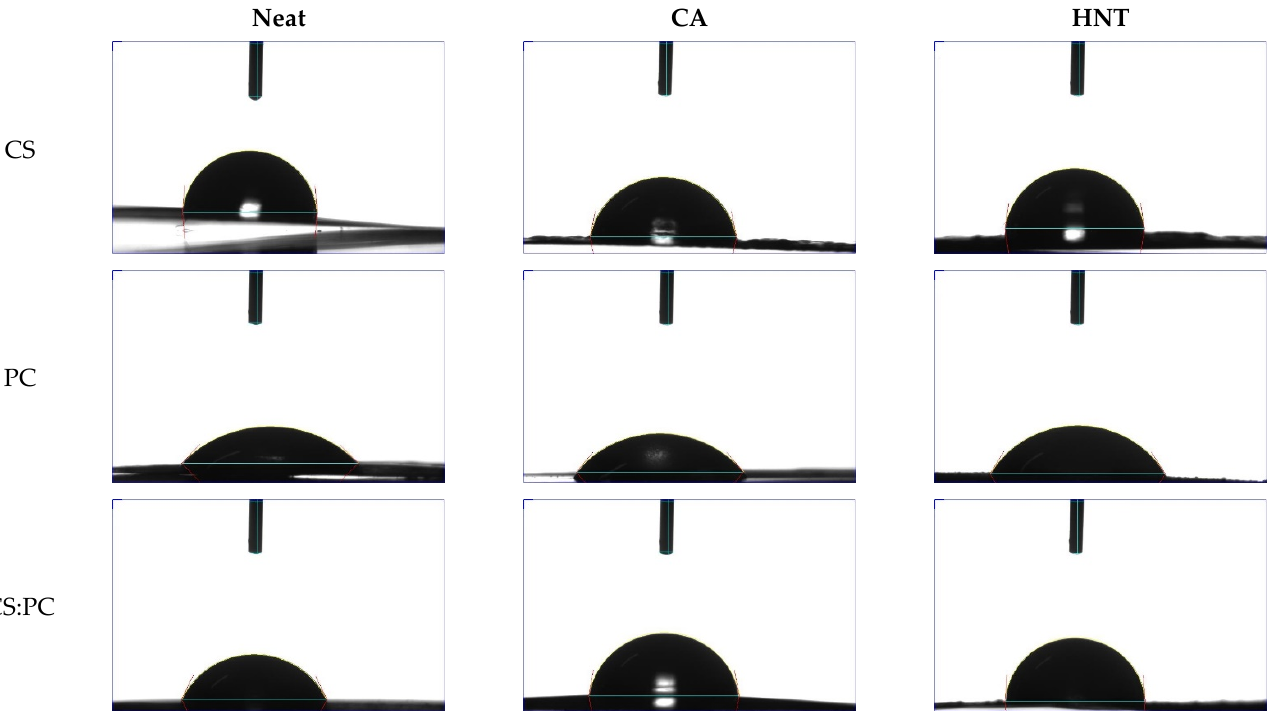
Figure 1. Frame of water contact angle (WCA) immediately after drop deposition on the biopolymer films surface. Table 1. Water contact angle (WCA) values of all investigated samples.